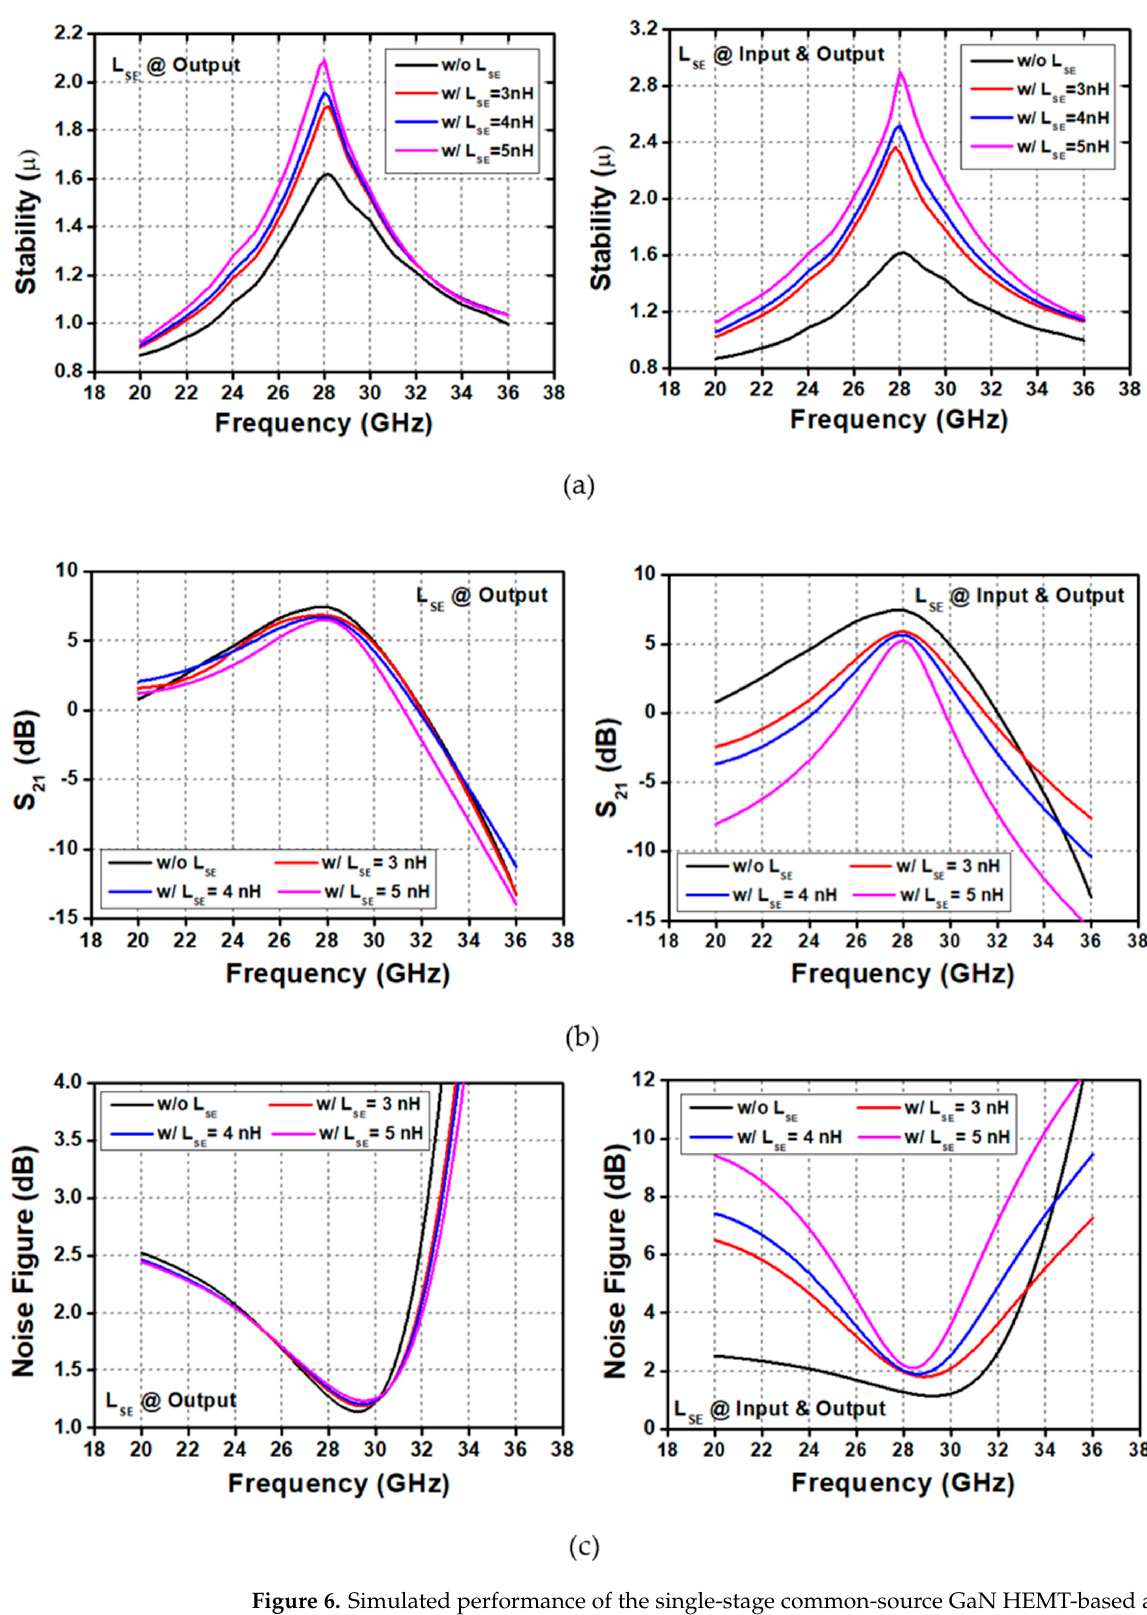
Figure 6. Simulated performance of the single-stage common-source GaN HEMT-based amplifier configuration with different values of series inductors at the drain node (output) (Figure 5a) and at both gate and drain nodes (input and output) (Figure 5b); ( a ) stability µ criteria, ( b ) small-signal gains ( S21 s), and ( c ) noise figures.